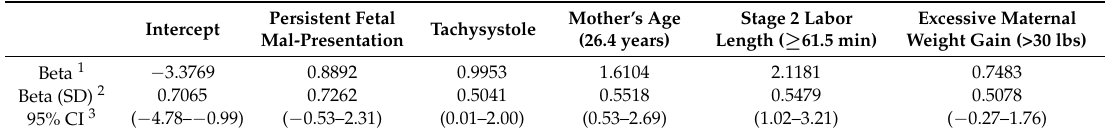
Table 4. Initial parameter estimation of the multiple logistic regression model showing the predicted calculated probability for each case without missing data